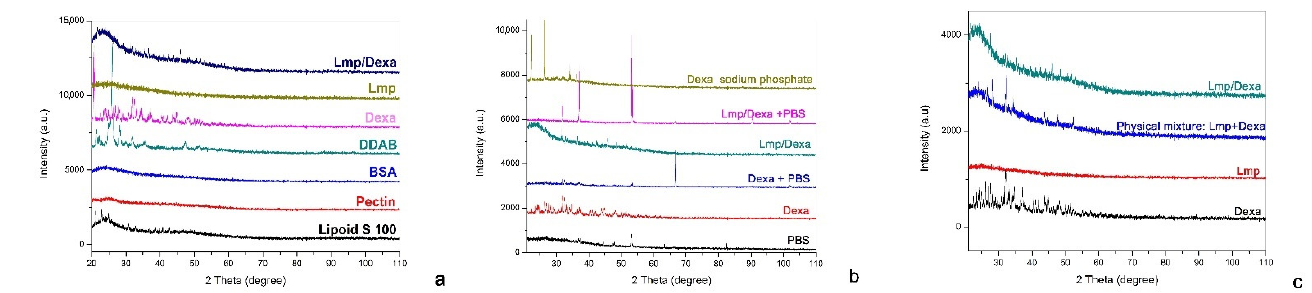
Figure 2. X-ray diffraction patterns of: Lmp and Lmp/Dexa and the precursors (Lipoid S 100, P, BSA and DDAB, Dexa) used for Lmp and Lmp/Dexa synthesis ( a ); dried PBS, Dexa, Dexa recovered from suspension in PBS, Lmp/Dexa, and Lmp/Dexa recovered from suspension in PBS, and Dexa sodium phosphate ( b ); pure Dexa, Lmp and the physical mixture of Lmp+Dexa, and Lmp/Dexa ( c ).